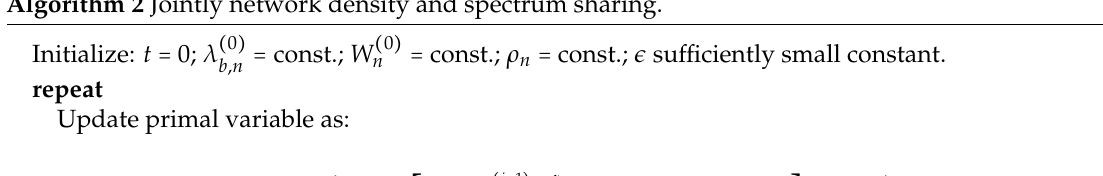
Algorithm 2 Jointly network density and spectrum